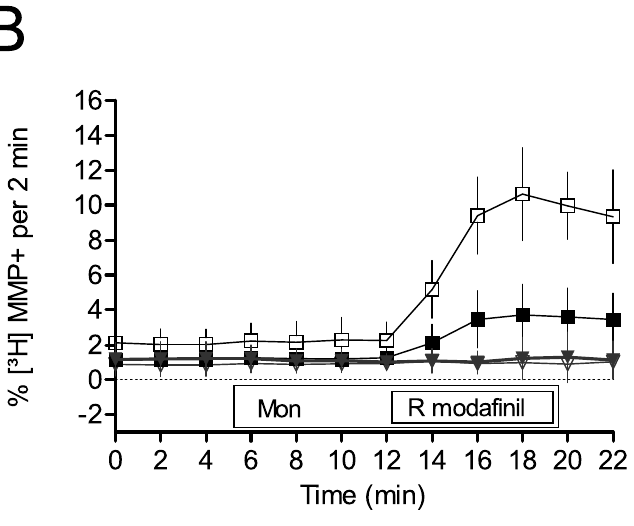
PLOS ONE | https://doi.org/10.1371/journal.pone.0179675 June 23,